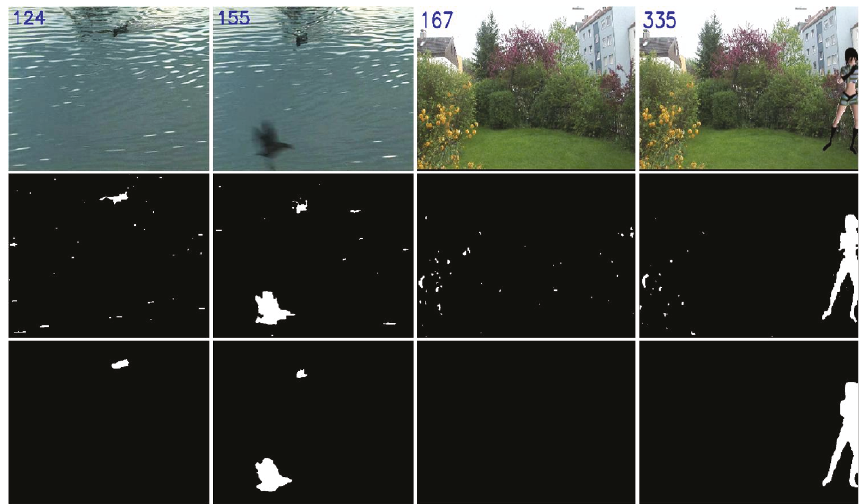
Figure 3: Comparison results of the KDE algorithm and its variation using local histogram of figure/ground segmentations on the two dynamic scenes. The first two columns are from a scene contains ripples in the water. The last two columns are from a scene contains heavily swaying trees. The first row contains original video frame. The second and third row contains the detection results of the KDE algorithm and its variation, separately.